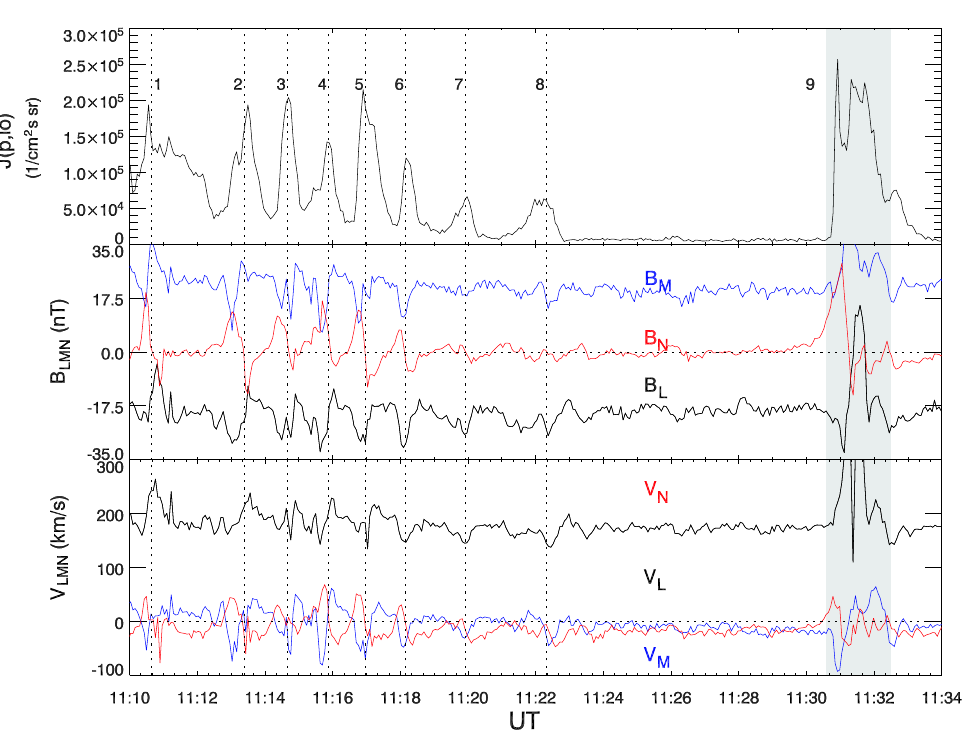
Fig. 3. The multiple flux rope event observed by Cluster (C3) on 26 January 2001. The panels, from top to bottom are: the flux of energetic protons, the magnetic field and the velocity of plasma in the MP boundary normal coordinates (LMN). The eight vertical dash lines mark the flux ropes and the light green shadow masks the FTE.